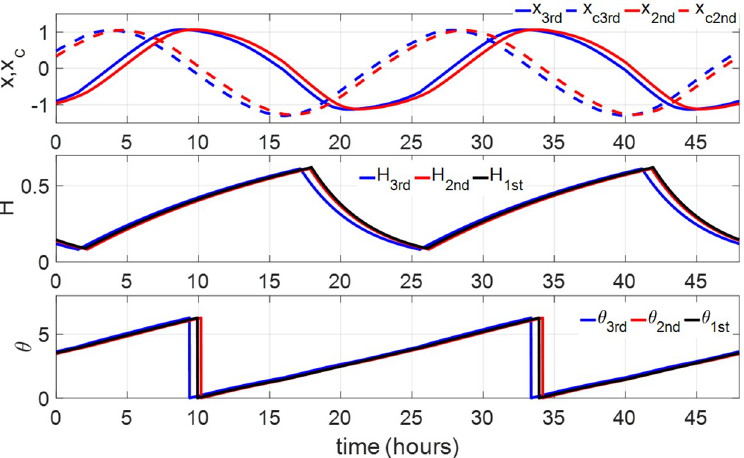
, H 3rd , θ 3rd c 3rd